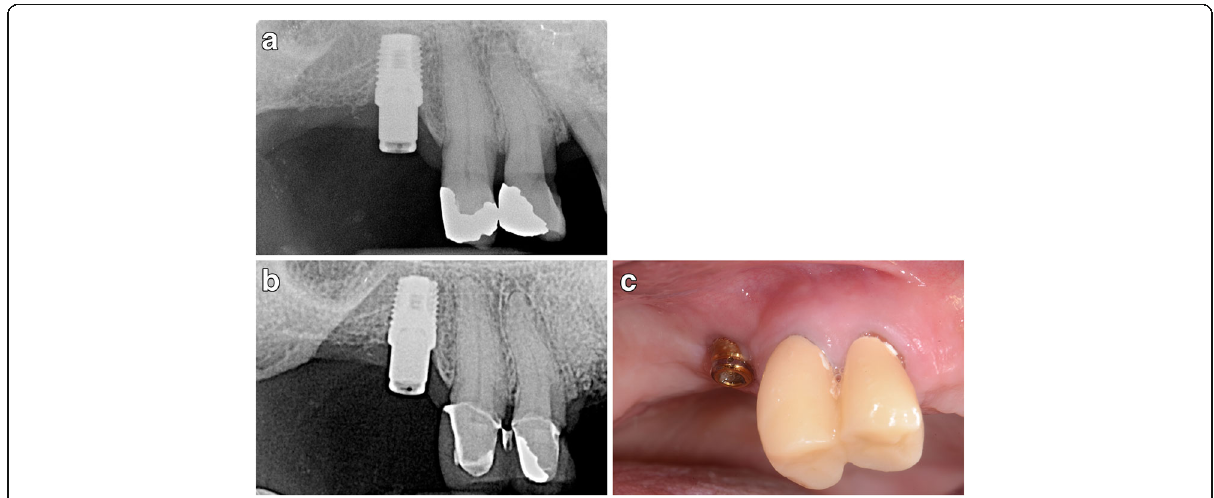
Fig. 1 a Initial radiograph exposed at abutment installation on a 5-mm-wide by 7-mm-length dental implant used to help support a removable partial denture for a 71-year-old Caucasian male. b Radiograph of the area taken at 82 months demonstrates good bone stability. c Clinical image of the area 82 months later. Soft tissue remains healthy. The two teeth anterior are in the process of receiving a two-unit fixed